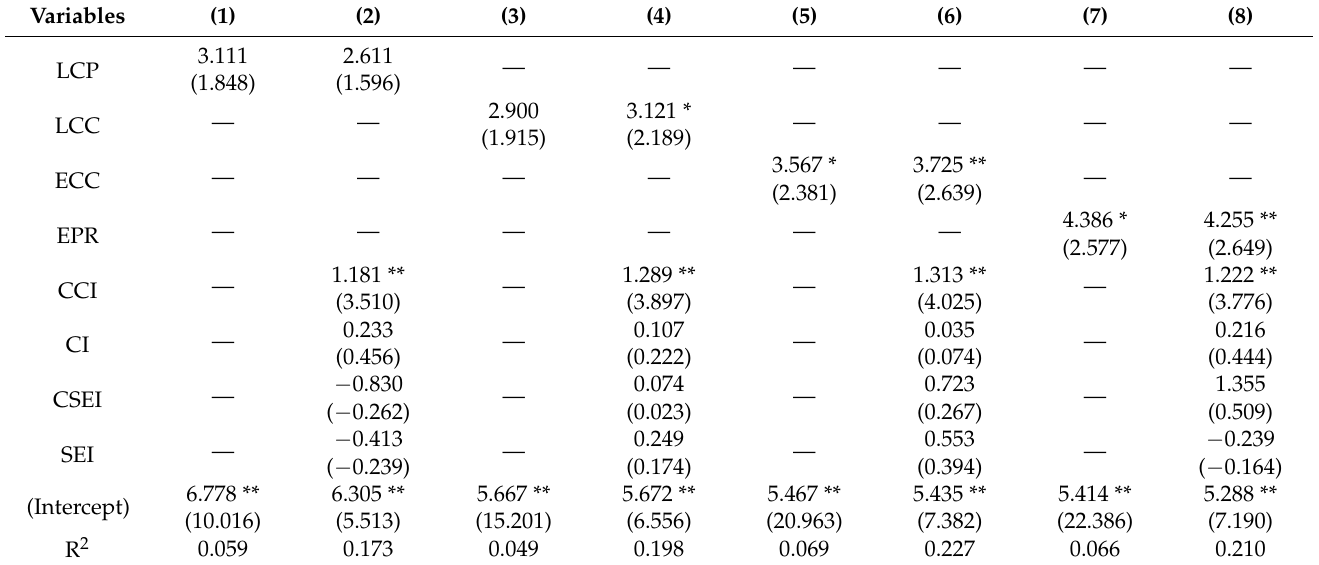
Table 5. Results of DID